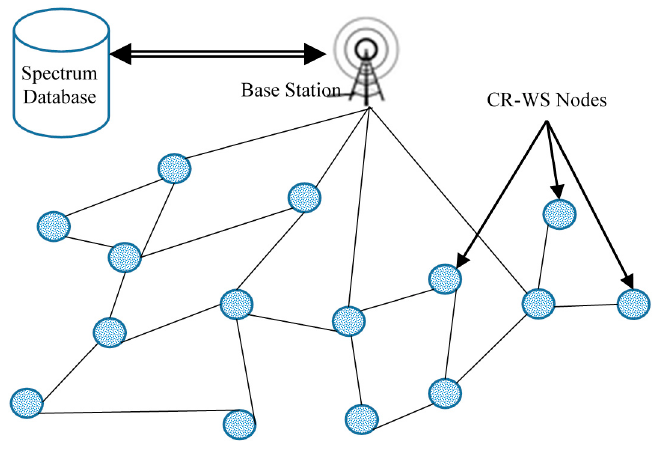
Figure 2. Flat network topology with all CR-WS nodes.